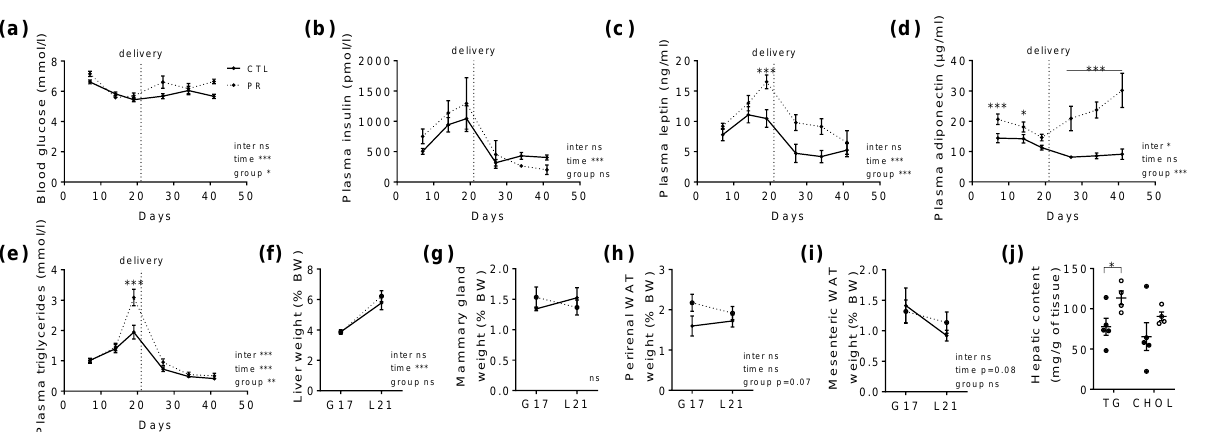
Figure 3. Plasma parameters and adiposity follow-up of dams during gestation and lactation. Blood glucose ( a ), plasma insulin ( b ), leptin ( c ), adiponectin ( d ), and triglyceride ( e ) levels have been followed during gestation (from D1 to D21) and lactation (from D22 to D42). At weaning, mothers have been sacrificed and liver ( f ), mammary gland ( g ), perirenal ( h ), and mesenteric ( i ) white adipose tissues have been weighed. Triglyceride and cholesterol contents ( j ) have been assayed in the liver. Solid line, CTL; Dotted line, PR. Vertical dotted line at D21 indicates delivery. CTL, control. PR, protein restriction; WAT, white adipose tissue; TG, triglycerides; CHOL, cholesterol. Data are mean ± SEM or individual values ( n = 2 – 13). * p < 0.05, ** p < 0.01, *** p < 0.001 vs. CTL, 2-way ANOVA with Sidak post-test.